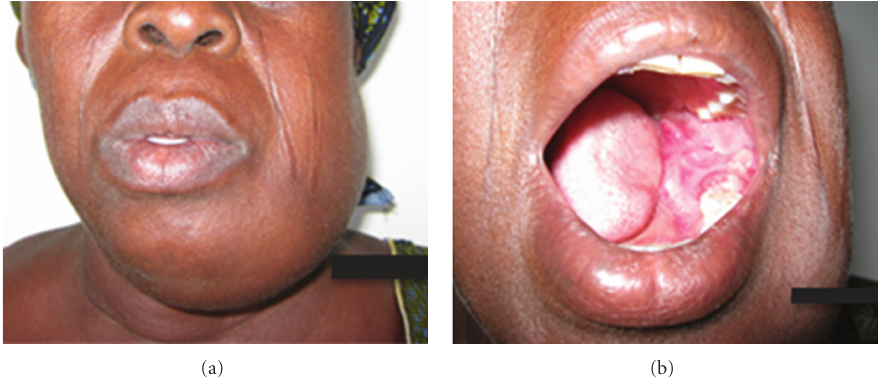
Figure 1: Clinical picture of case 1.